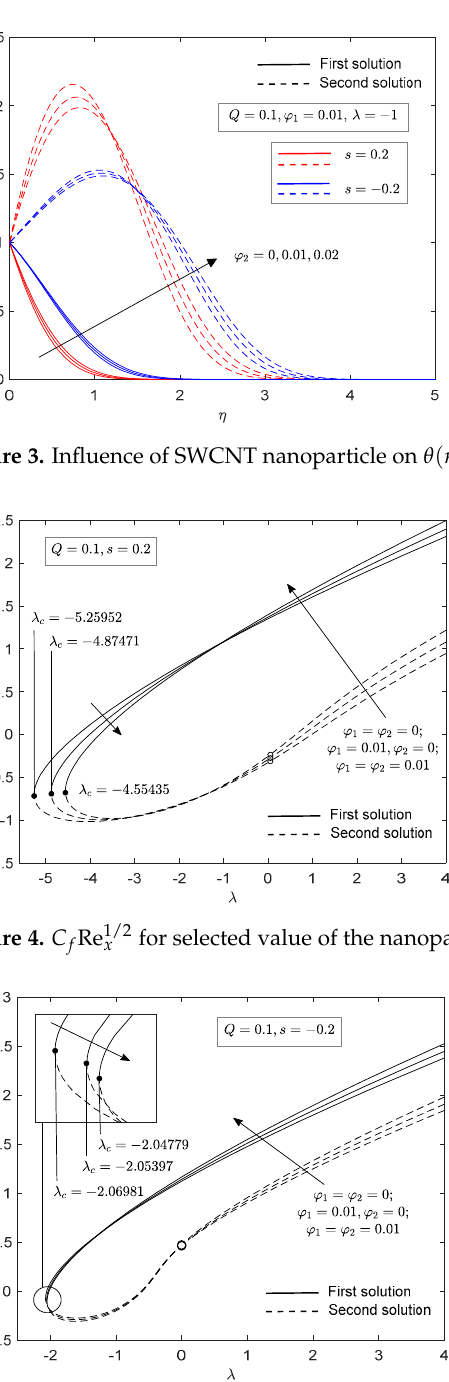
C for some value of the nanoparticle when 0.2 s = − . Figure 5. C f Re 1/2 x for some value of the nanoparticle when s = − Figure 5. 1/2 Re f x